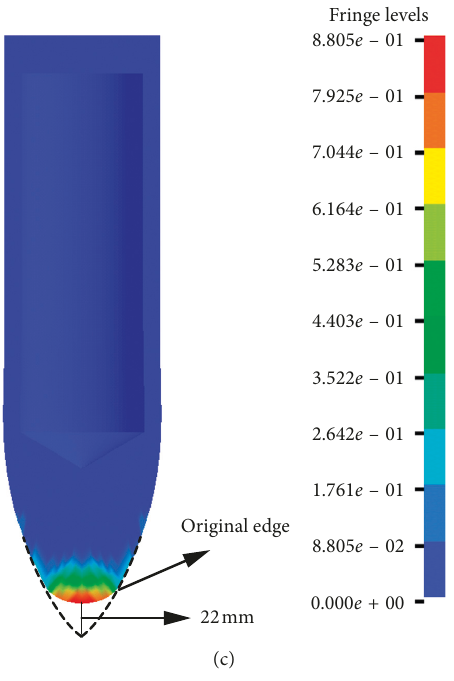
Figure 17: The damage of projectiles: (a) 60mm FC target; (b) 100mm FC target; (c) 160mm FC target.